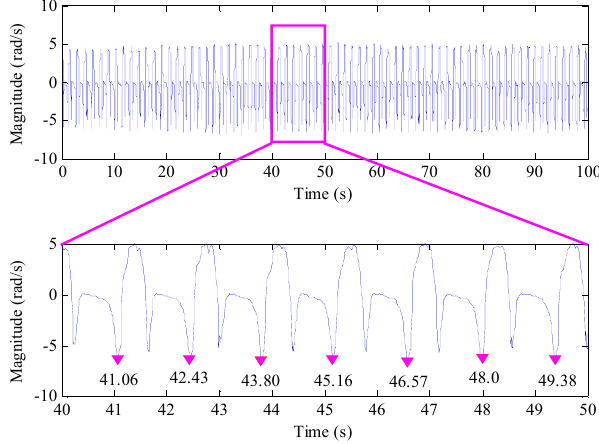
Figure 4. The time domain waveform of the y axis gyroscope output and its local enlarged drawing.